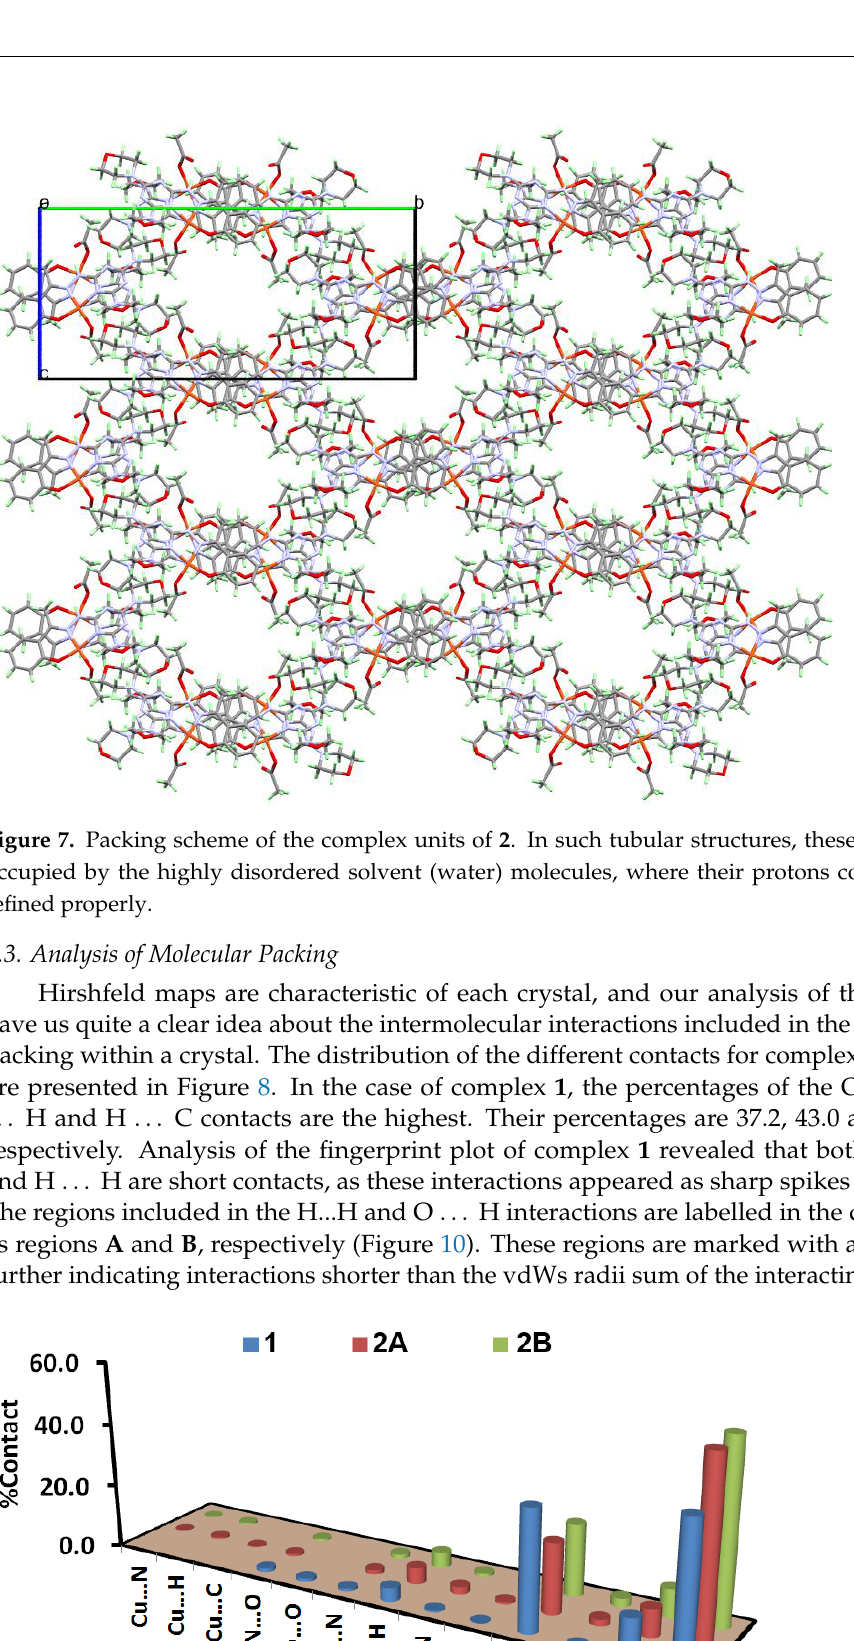
Figure 9. Decomposed fingerprint plots in complex 1 .